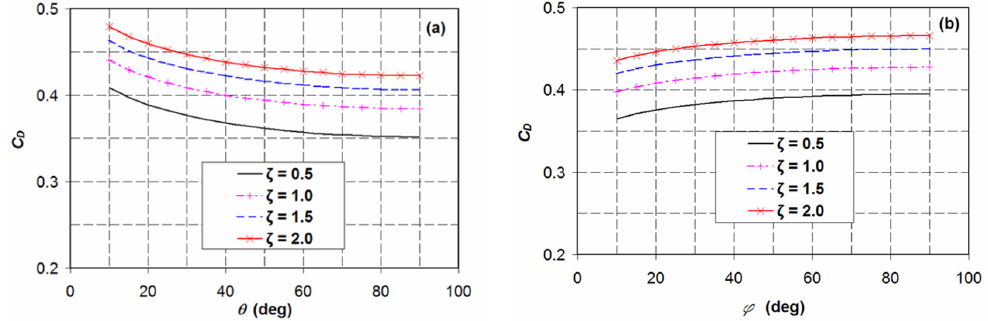
Figure8. Typicalvariationoffree-flowdischargecoefficientwiththe( a )upstream-and( b )downstream-face Figure 8. Typical variation of free-flow discharge coefficient with the ( a ) upstream- and ( b ) slopes for various values of relative overflow head ζ . ϕ and θ in ( a ) and ( b ), respectively, kept at 26.57 ◦ downstream-face slopes for various values of relative overflow head  .  and  in ( a ) and ( b ), respectively, kept at 26.57°.